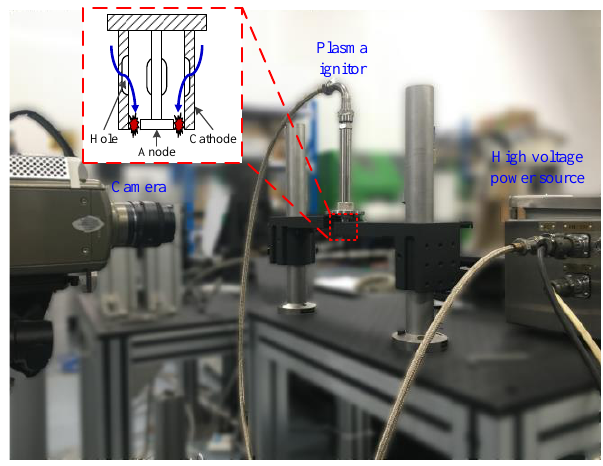
Figure 1. Schematic of the plasma ignition experiment setup.